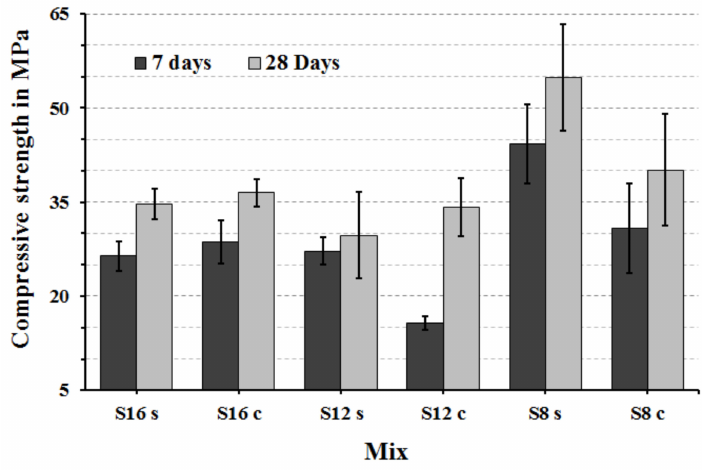
Figure 8. Seven and 28 d compressive strength results of the AASs